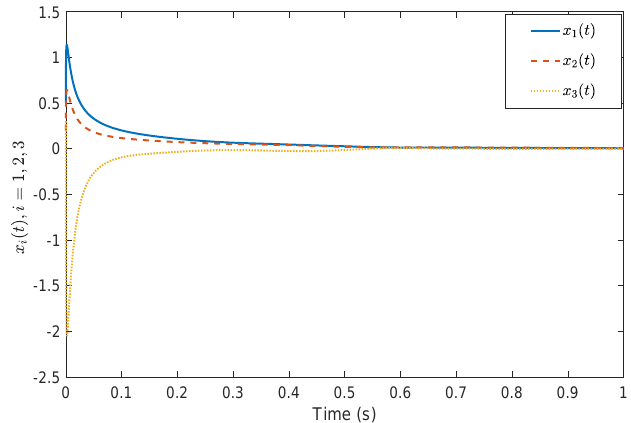
Figure 2. States x (t) by the fixed-time controller in [26].